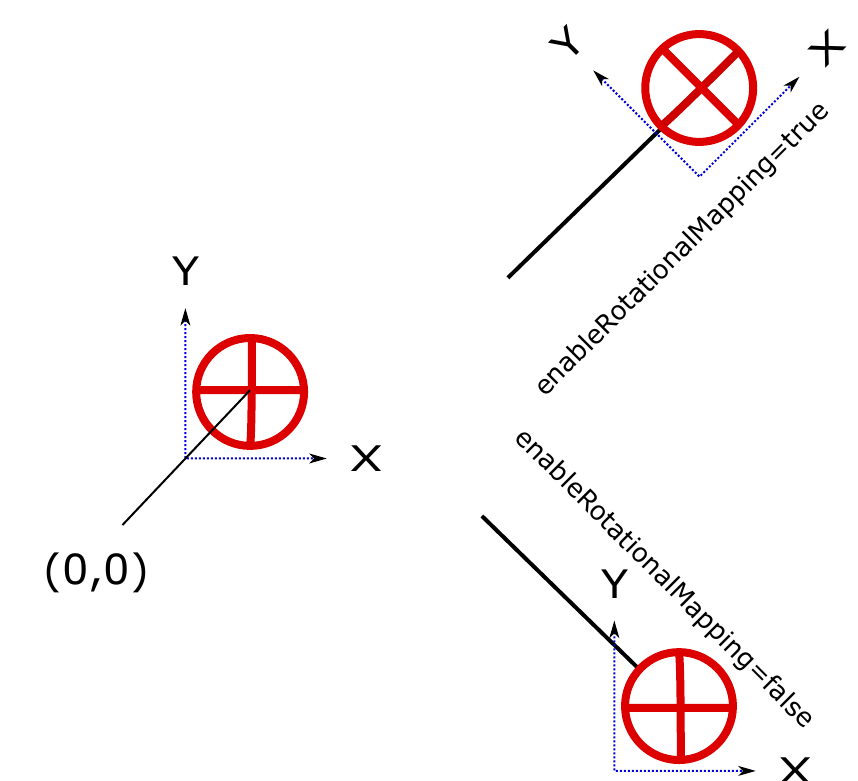
Figure 15: example of a line ending with and without rotation mapping